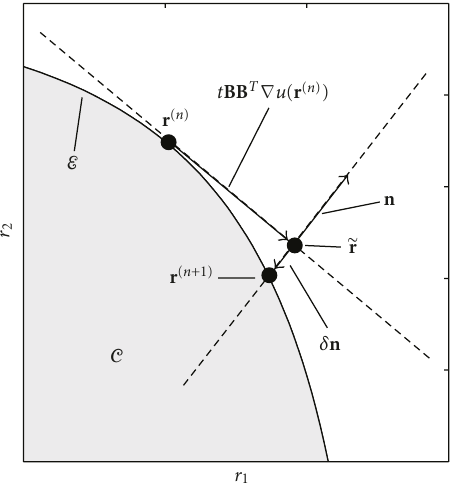
Figure 1: One iteration of the IEA